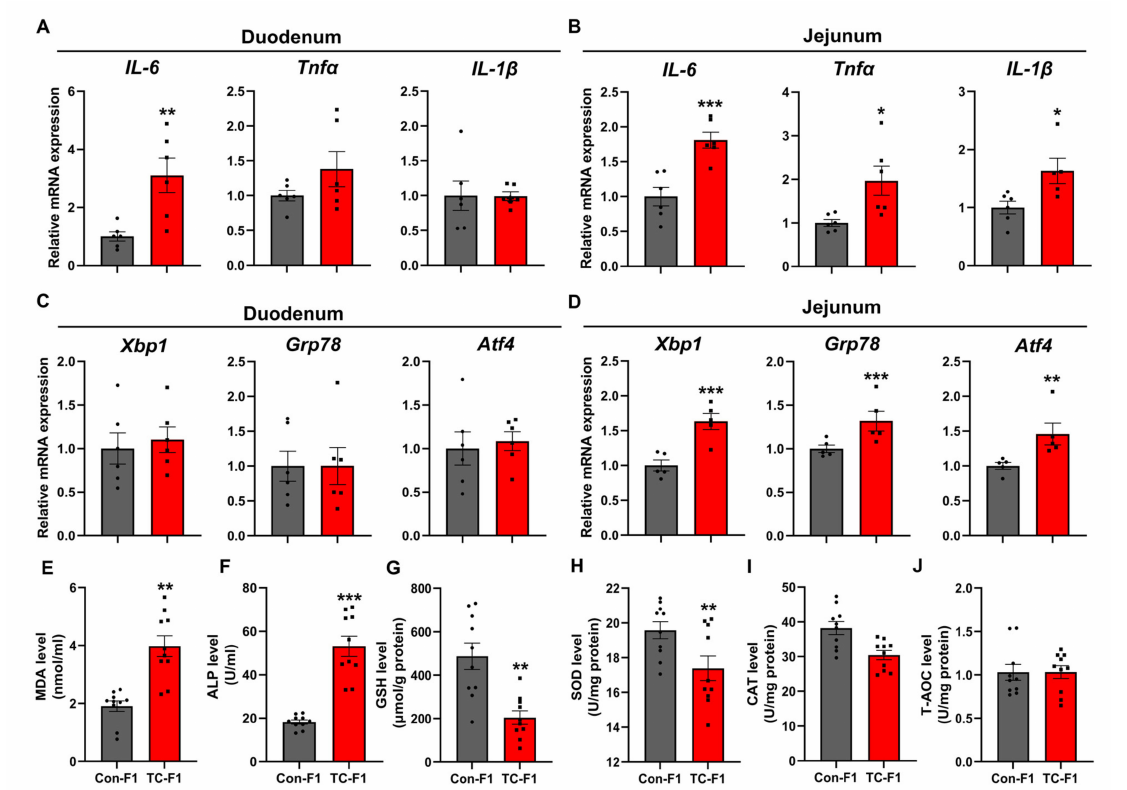
Figure 6. TC exposure in early life results in slight inflammation and oxidative stress in the jejunum of female offspring. ( A , B ) mRNA expression of inflammatory markers IL-6 , Tnf α and IL-1 β in the duodenum ( A ) and jejunum ( B ) of 8-week-old offspring female mice, n = 5-6. ( C , D ) mRNA expression of oxidative stress marker genes Xbp1 , Grp78 and Atf4 in the duodenum ( C ) and jejunum ( D ) of 8-week-old offspring female mice, n = 5-6. ( E – J ) Levels of MDA ( E ), ALP ( F ), GSH ( G ), SOD ( H ), CAT ( I ) and T-AOC ( J ) markers associated with oxidative stress, in the jejunum of 8-week-old female offspring mice, n = 10. Data are expressed as mean ± SEM. * p < 0.05, ** p < 0.01, *** p < 0.001 vs.